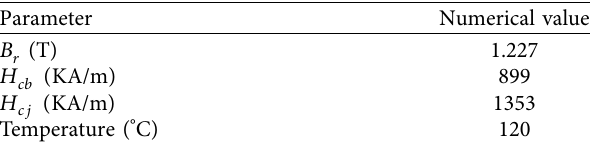
Table 2: Magnetic property